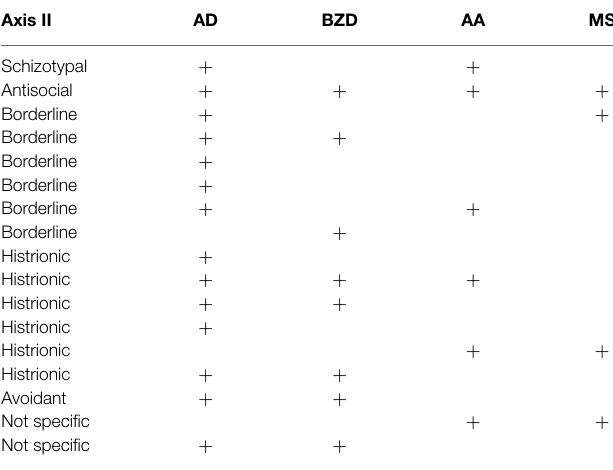
TABLE 1 | Diagnostic and medication data of PD patients.